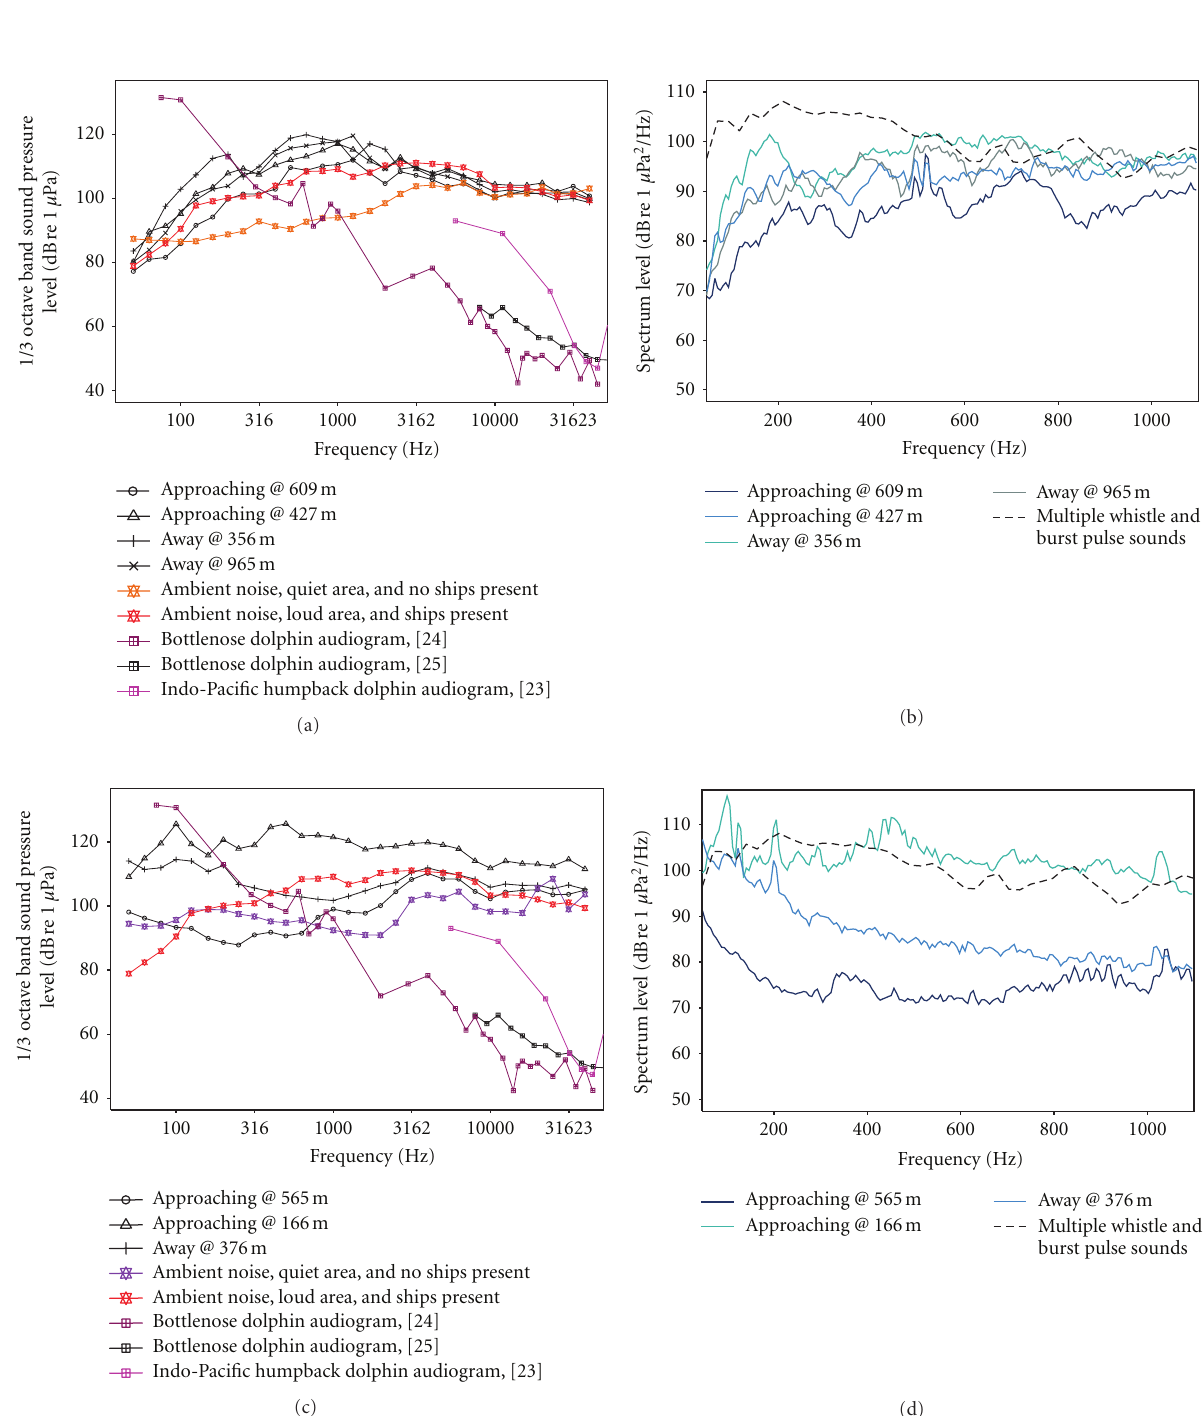
Figure 4: The various sound pressure level contributions of a high-speed ferry (R66; a), at West Lantau number 3 with a Beaufort sea state of 2. The orange line indicates the ambient sounds of Southwest Lantau number 2, located between the Soko Islands with very little boat tra ffi c and no vessels present during recording. The red line indicates South Lantau Vessel Fairway, a busy tra ffi c area, especially for ferries. South Lantau Vessel Fairway was recorded with several ferries and a shrimp trawler present. (b) shows selected sound spectra of the above high-speed ferry in comparison to the spectra of humpback dolphin communication sounds at a distance of ≤ 100 m. (c) The various sound pressure level contributions of a high-speed ferry (R92), at Northwest Lantau number 5 with a Beaufort sea state of 4. The ambient noise level (represented in purple) was taken from Northwest Lantau number 1, an area with very little boat tra ffi c, located within the Sha Chau and Lung Kwu Chau Marine Park. The red line is the same as that in (a). Sound spectra are represented below (d) for the high-speed ferry, including the same humpback dolphin spectra as